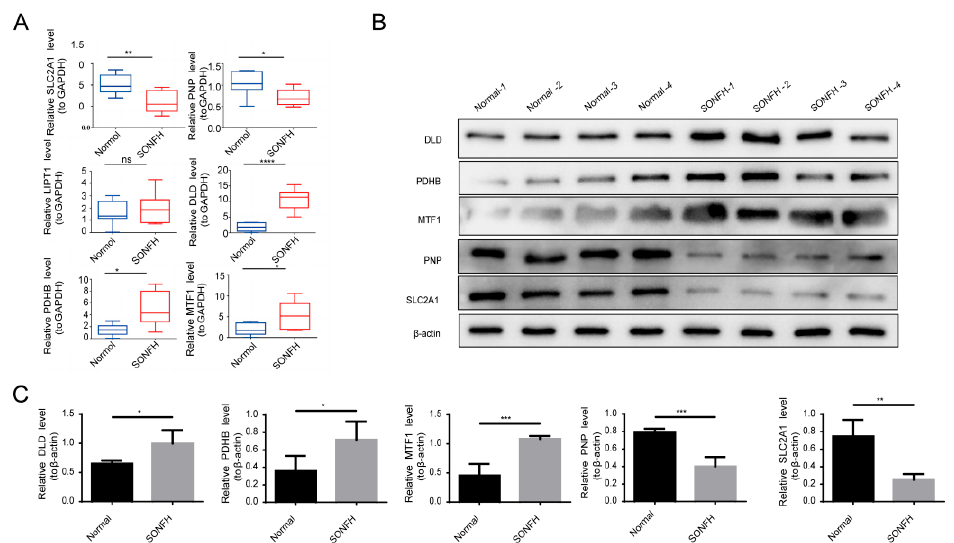
Figure 11. Expression vavification of the key genes, as well as the vital copper death-related genes. ( A ). PNP, SLC2A1, LIPT1, DLD, PDHB, and MTF1 expression levels were verified via quantitative real-time polymerase chain reaction (qRT–PCR) (n = 13). ( B , C ). DLD, PDHB, MTF1, PNP, and SLC2A1 expression levels were verified via Western blot (WB) analysis with quantification (n = 8),